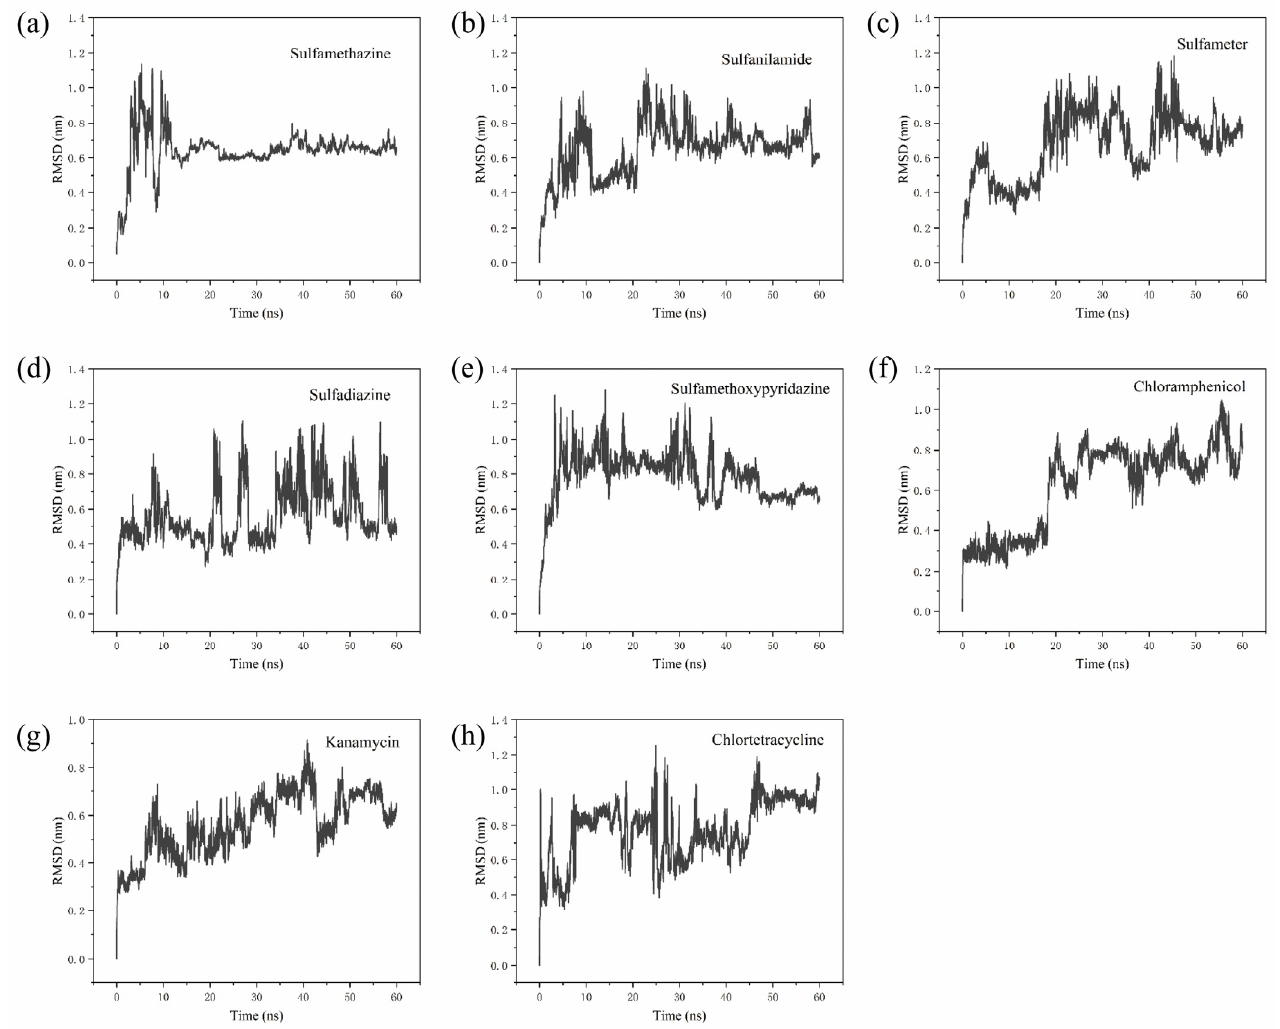
Figure 4. RMSD curve of SMZ1S with SMZ ( a ), sulfanilamide ( b ), sulfameter ( c ), sulfadiazine ( d ), sulfamethoxypyridazine ( e ), chloramphenicol ( f ), kanamycin ( g ), and chlortetracycline ( h ).